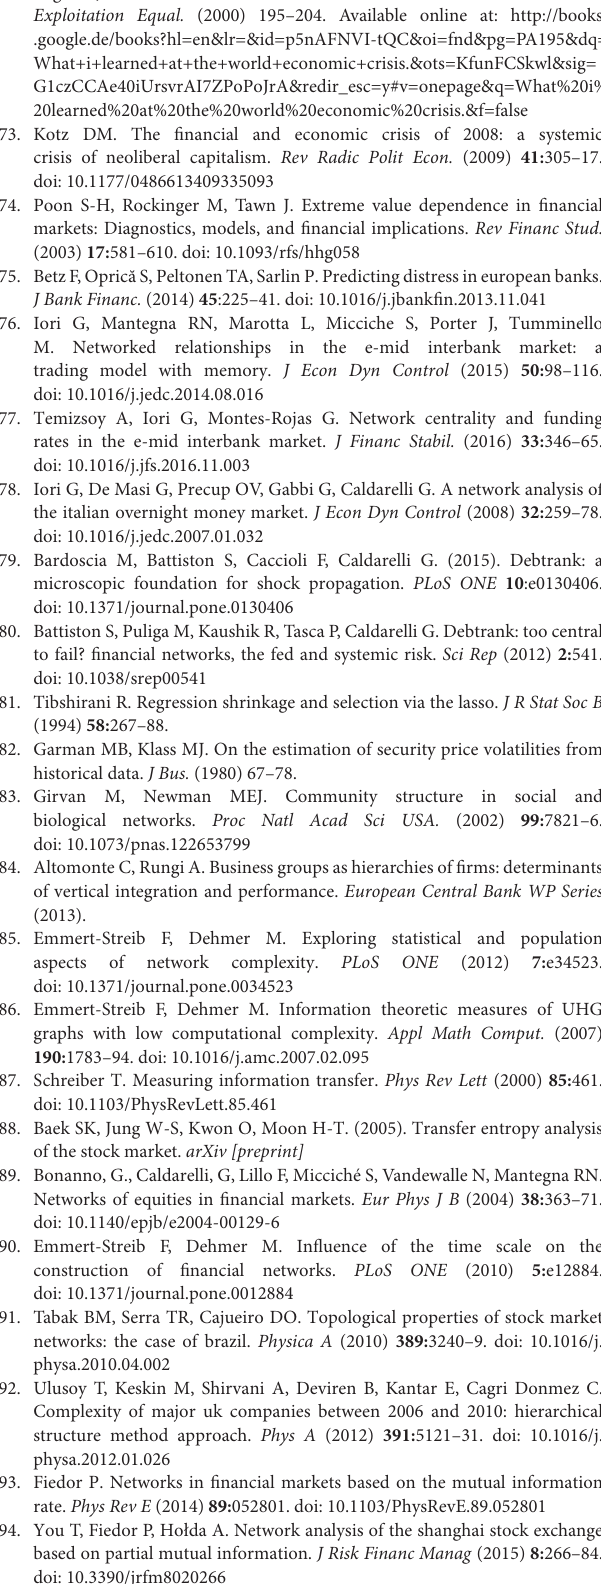
91. Tabak BM, Serra TR, Cajueiro DO. Topological properties of stock market networks: the case of brazil. Physica A (2010) 389: 3240–9. doi: